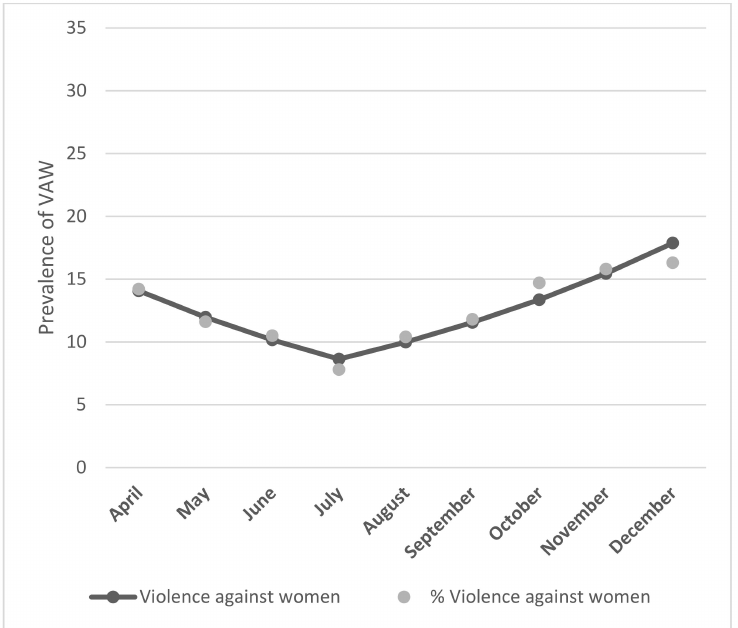
Figure 1. Violence against women during the COVID-19 pandemic: temporal analysis of prevalence with joinpoint regression. July: β = − 0.16, p < 0.01, December: β = 0.30, p < 0.001, Average monthly change: 14.85%, 95% CI [9.9, 21.7], p <